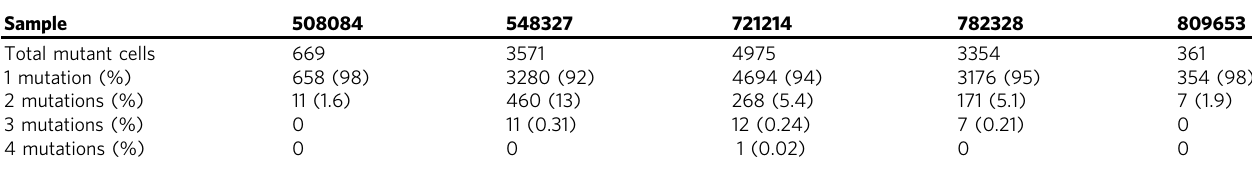
Table 2 Frequency of cells containing multiple mutations in each case